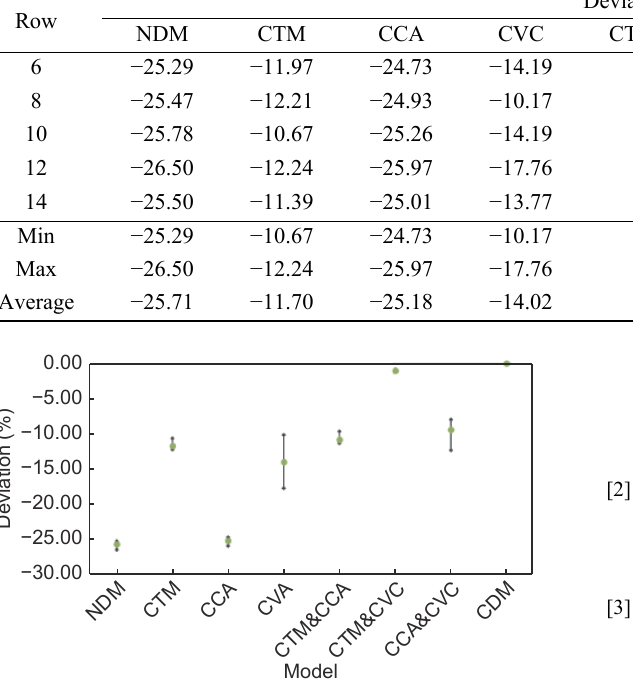
Fig. 15 Makespan deviation in different row numbers of different